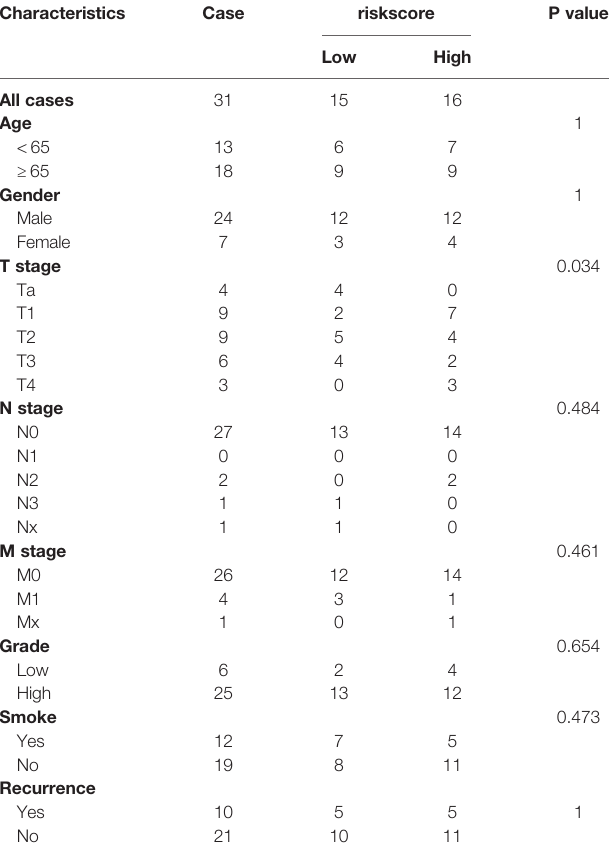
TABLE 3 | Clinicopathological characteristics of patients in the original